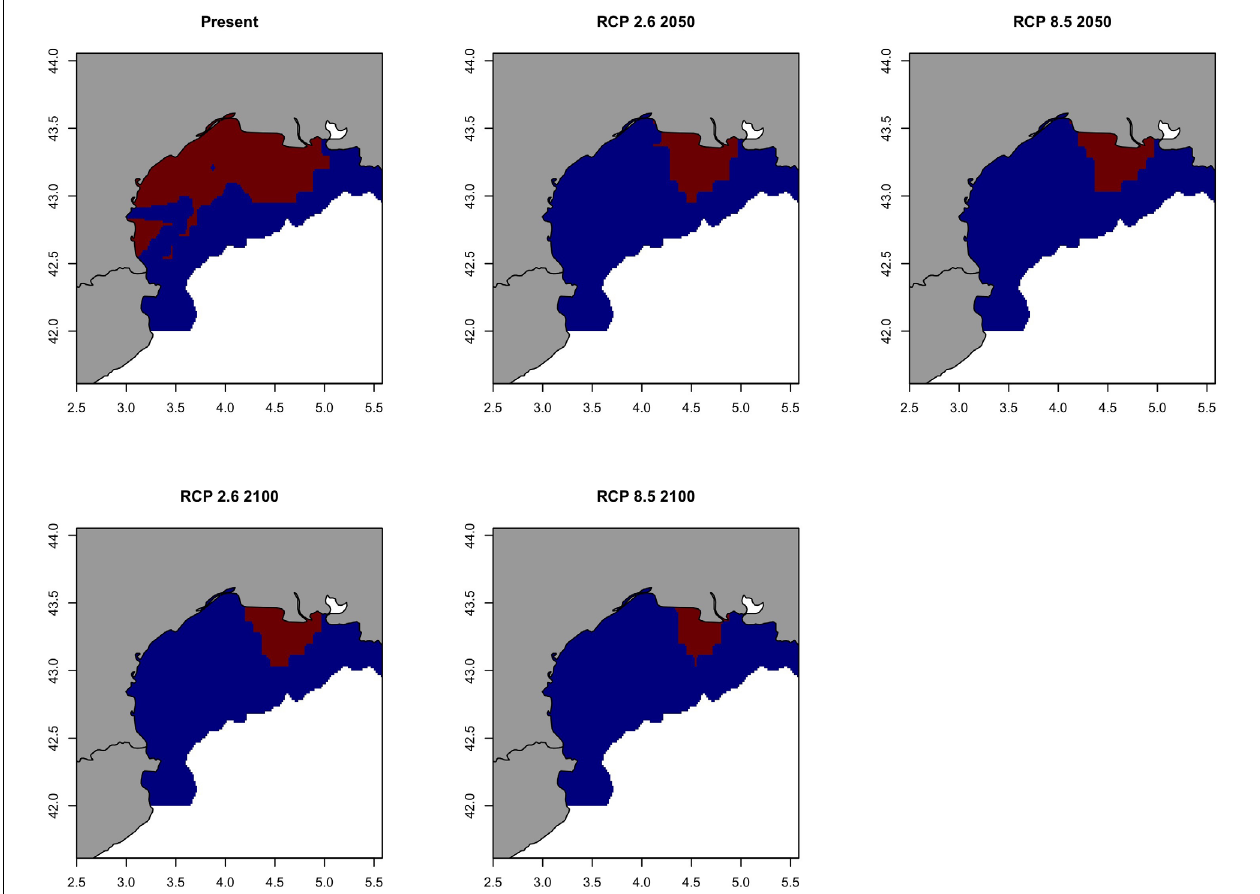
FIGURE 11 | Climate refuges, hot-spots of the probability of occurrence ( > 0.7) of the European sardine ( Sardina pilchardus ) in Geographical Sub-Area 07 for the present situation and using IPCC pathway scenarios obtained with RAC-BRT models. Red color indicates probability of occurrence > 0.7, while blue < 0.7.